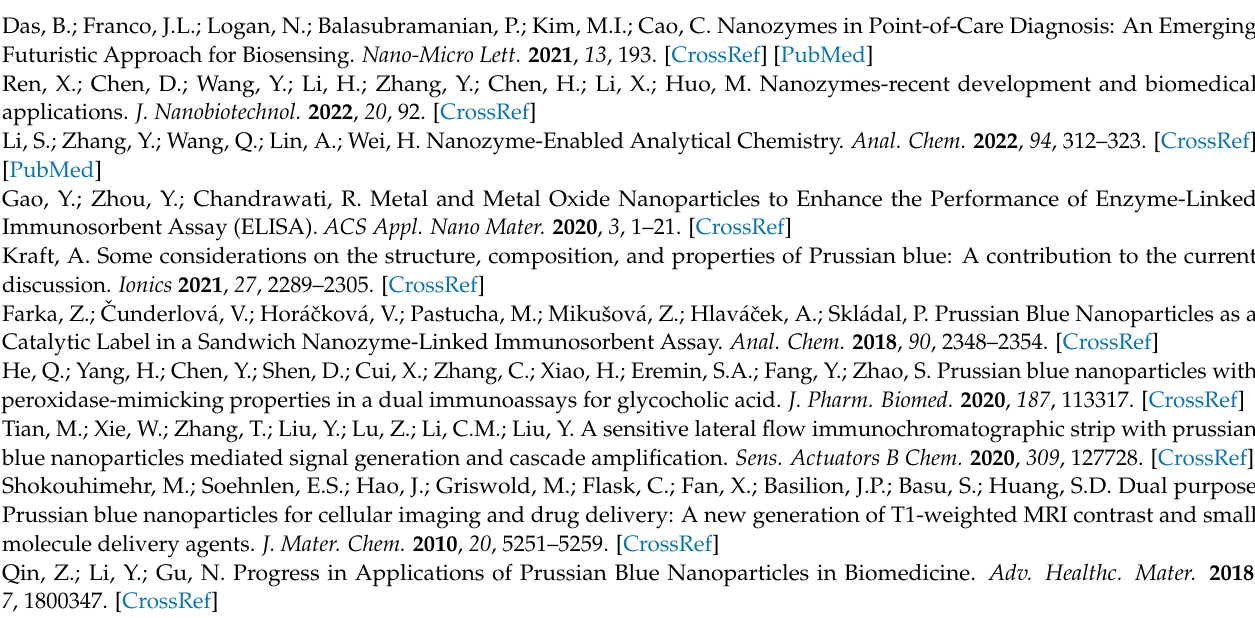
Figure S4. Intensity-weighted size distribution plots; Figure S5. Elemental analysis (EDS) of PB@BSA5; Figure S6. Elemental analysis (EDS) of BSA NPs; Figure S7. Intensity-weighted size distribution plots; Figure S8. Decrease in zeta potential of PB@BSA5 after the glutaraldehyde treatment; Figure S9. Re-testing of substrates provided the highest signal; Figure S10. Dynamics of color intensity change at different H 2 O 2 concentration in substrate solution; Figure S11. Optimization of PSA assay conditions; Figure S12. PSA assay: results of curve